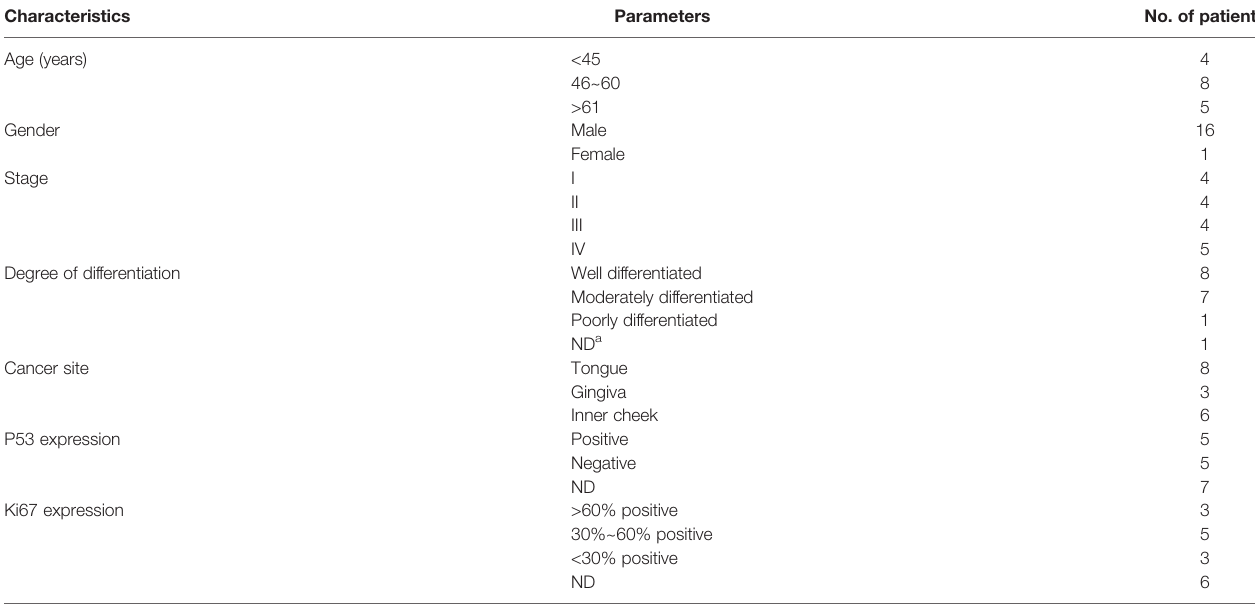
TABLE 1 | Patient demographics and clinical